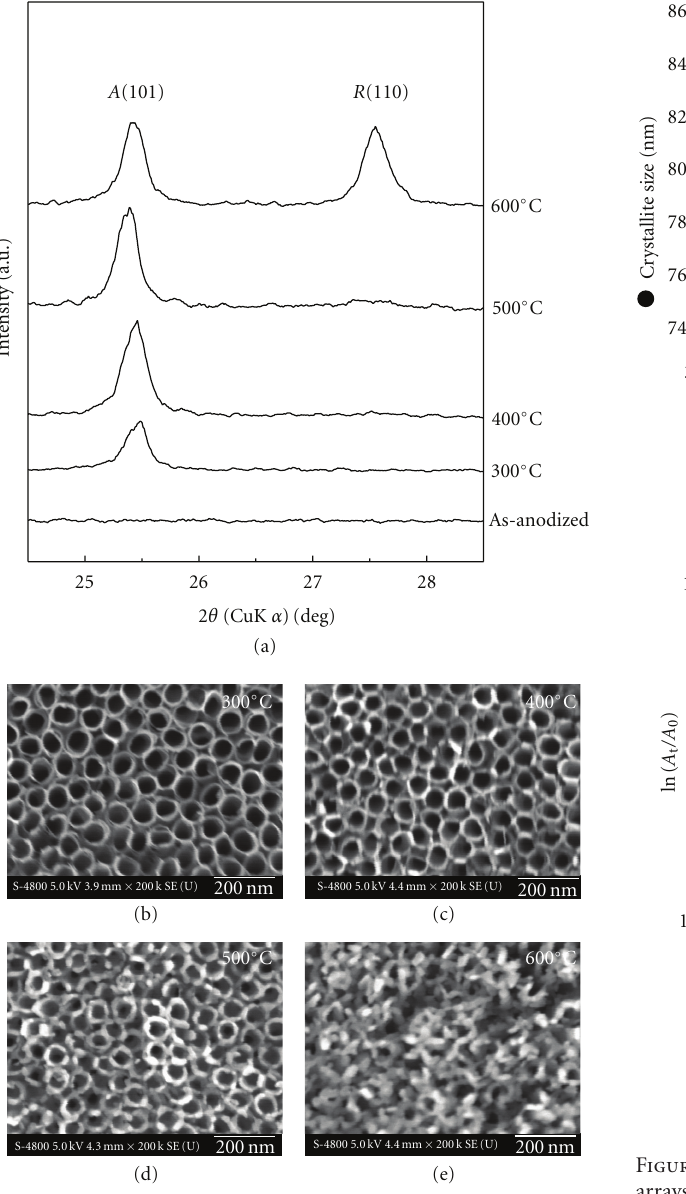
Figure 2: The titania nanotube arrays (TNAs) of as-anodized and annealed at 300 to 600 ◦ C: (a) X-ray di ff raction patterns; (b,c,d,e) surface morphologies.